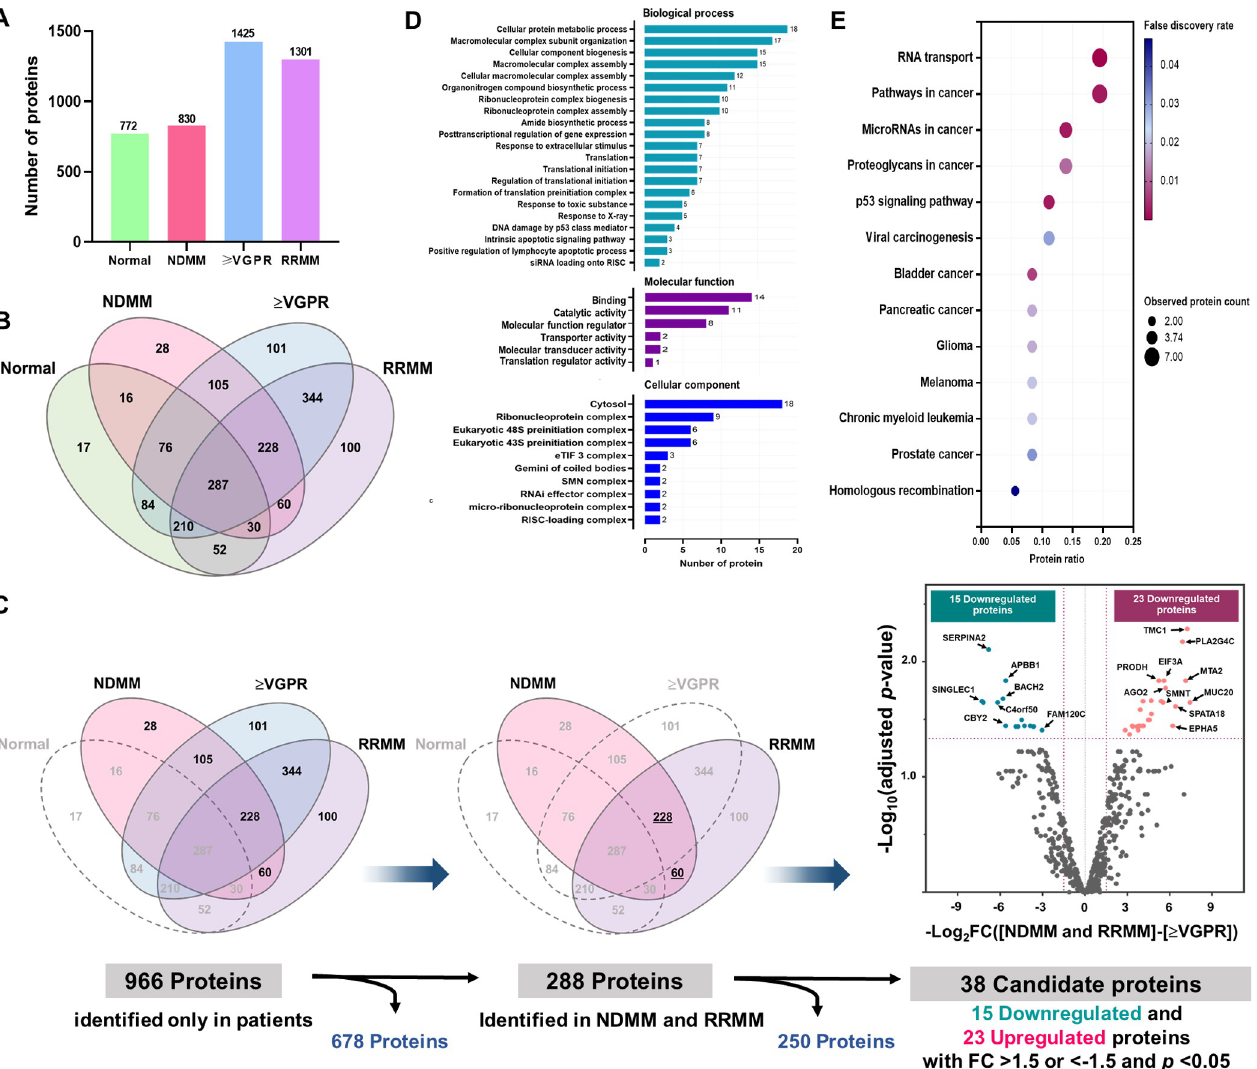
Fig 2. Differentially expressed proteins identified by LC-MS/MS in the discovery phase. (A) Bar chart demonstrating the number of serum proteins identified in each group. (B) Venn diagram illustrating the overlap between the serum proteins detected in normal, NDMM, � VGPR and RRMM. (C) The overview of candidate biomarker screening processes. Volcano plot demonstrating the change in the relative abundance of 288 proteins between disease-active states (NDMM and RRMM) and disease remission states ( � VGPR). The x-axis represents log 2 fold changes of proteins, and the y-axis represents -log 10 FDR- adjusted p -values. The rose pink and blue-green dots represent significantly upregulated and downregulated proteins with a log 2 -fold change > 1.5 and < -1.5, respectively. (D) GO functional enrichment analysis of the 38 dysregulated proteins. Bar charts demonstrate the distribution according to their biological process, molecular function and cellular component. (E) KEGG pathway enrichment analysis of the 38 dysregulated proteins. The y-axis indicates the functional classification or pathway, and the x-axis indicates the protein ratio (observed protein count/total identified protein) of the respective pathway. The color key of the FDR and bubble size represent the observed protein count in the respective